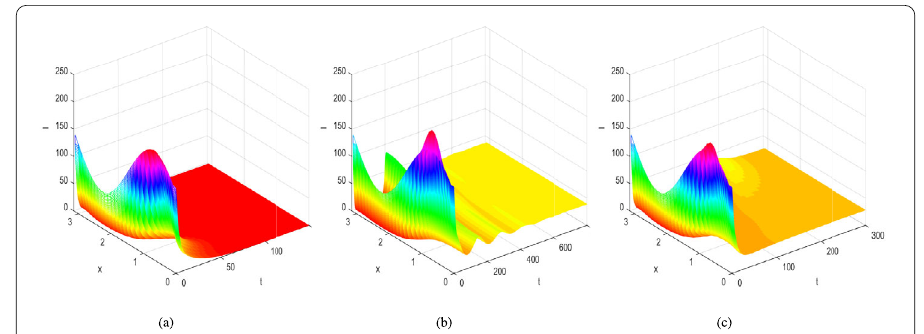
Figure 2 Simulations of system (2.1) for numbers of the infected individuals I ( x , t ) with respect to parameters β , I c . ( a ) β = 0.00005, I c = 30; ( b ) β = 0.00007, I c = 60; ( c ) β = 0.00007, I c =